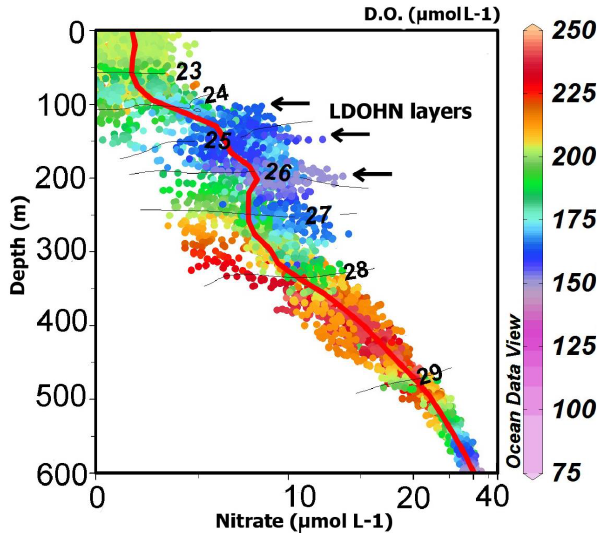
Fig. 5. Depth profile plot of nitrate concentrations with dis- solved oxygen concentrations overlay and in situ density con- tour lines in black, from 21 ◦ S transect. Several LDOHN lay- ers are visible just below the ρ = 24kgm − 3 density isoline, and between ρ = 25–26kgm − 3 isolines (black arrows) and below ρ = 27kgm − 3 . Note that oxygen is locally lowered below satura- tion in each LDOHN layer, but each layer has a different character- istic oxygen signal (seen as varying pale blue, dark blue and purple shading of dots). Data from transect 1 (Fig. 1f) were fitted through piece-wise linear least squares